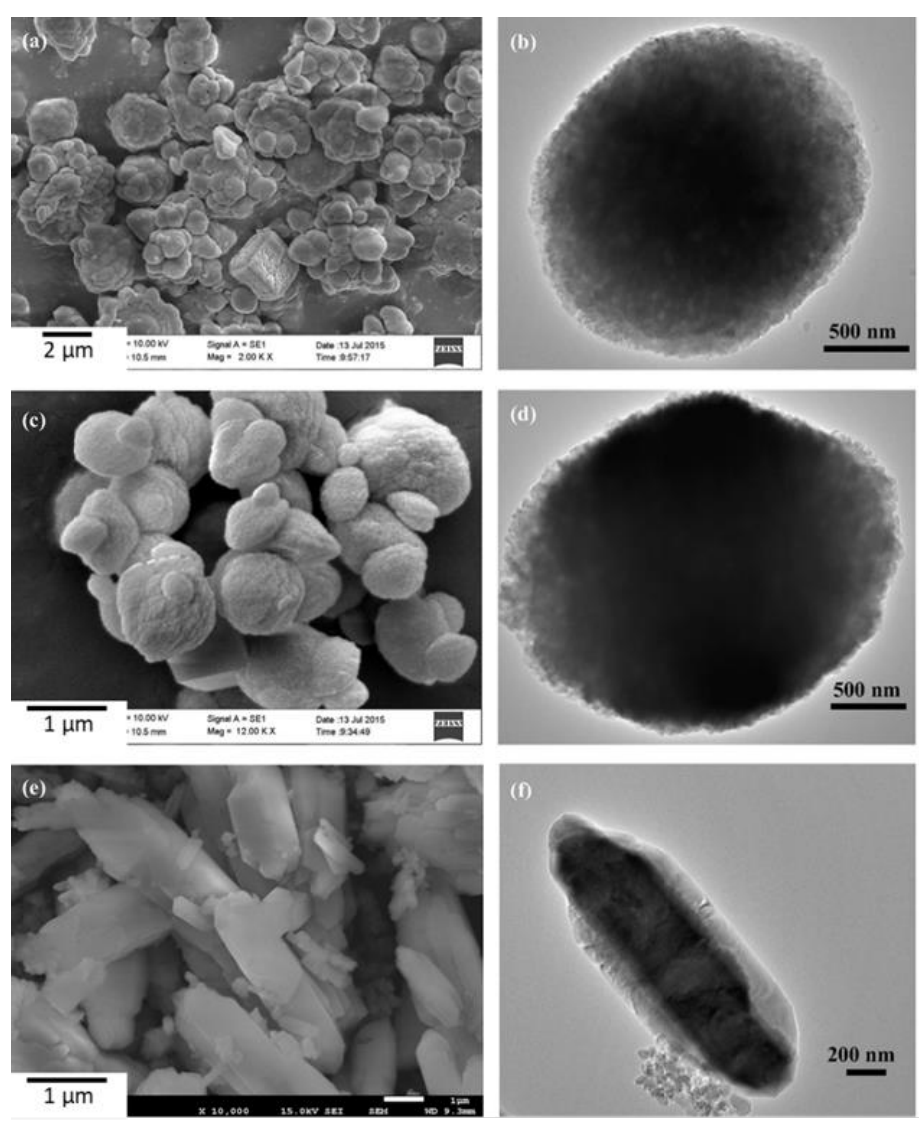
Figure 10. Morphology of micro-encapsulated paraffin in CaCO 3 shell: SEM images ( a , c , e ) and TEM images ( b , d , f ) [78].